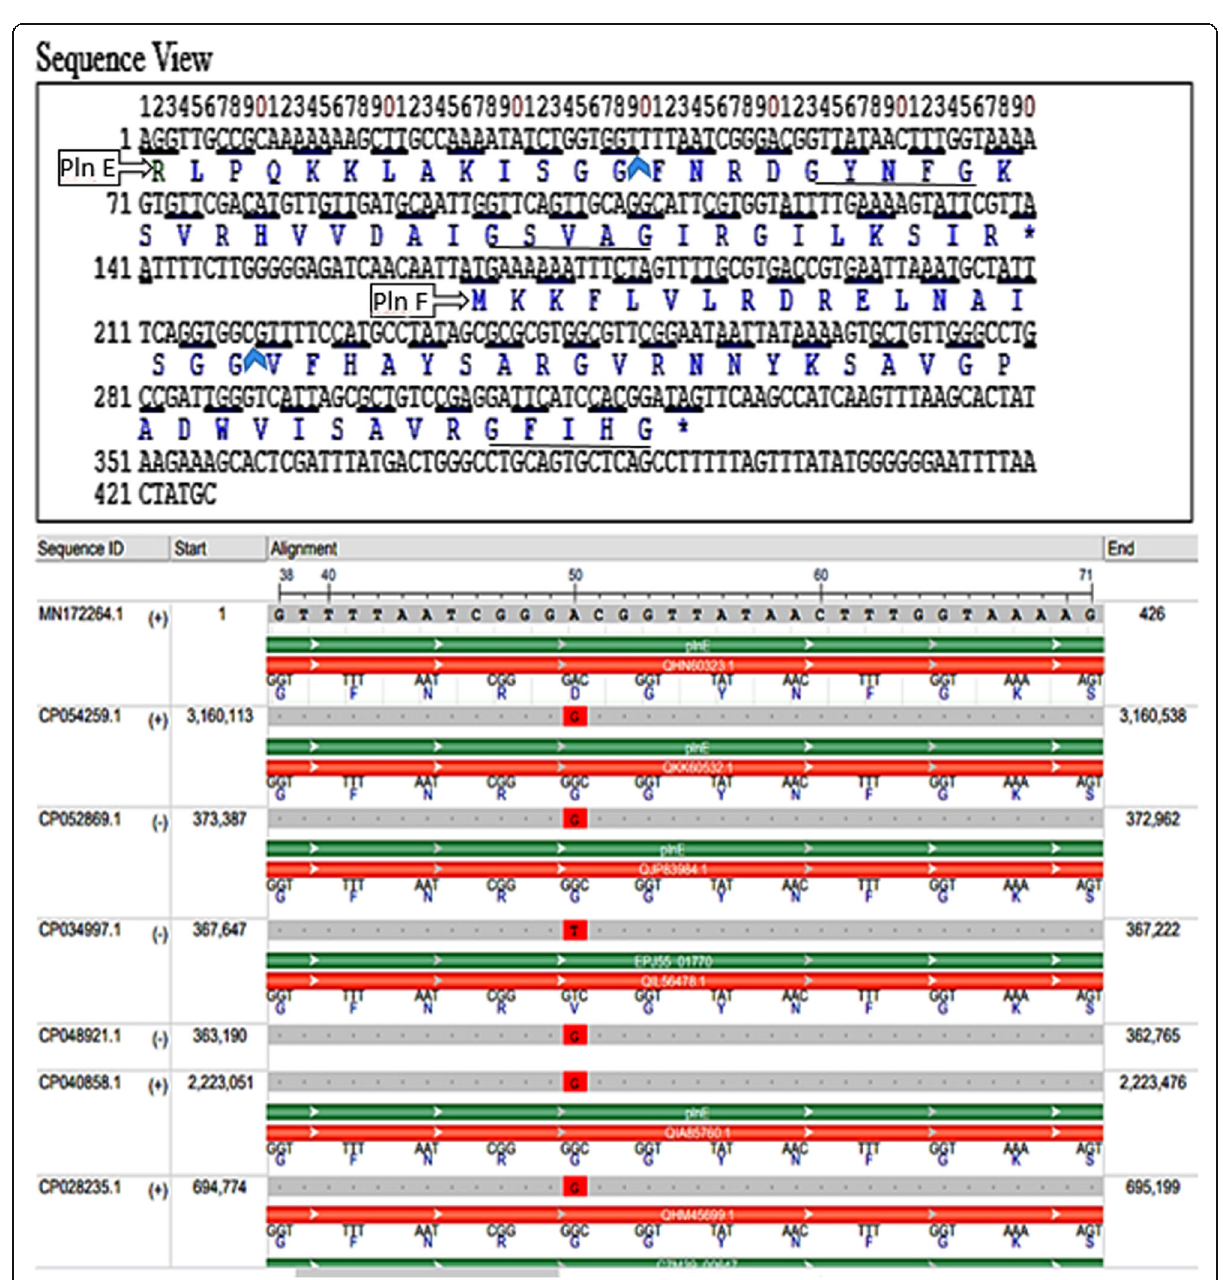
Fig. 3 The DNA sequence of the gene encoding plantaricin EF of Lactobacillus plantarum strain EG.LP.18.13 (MN172264.1). a Nucleotide and deduced amino acid sequences of pln EF; blue arrows indicate the cleavage sites in the PlnE and PlnF pre-mature peptides and the starts of the corresponding mature peptides, stop codons are indicated by asterisks at the ends of the protein sequences; GXXXG motives are underlined. b Multiple sequence alignment view of nucleotides of pre-mature fragment of plnE with other closely plnE peptides producing Lactobacillus strain references showing the dissimilar amino acids in